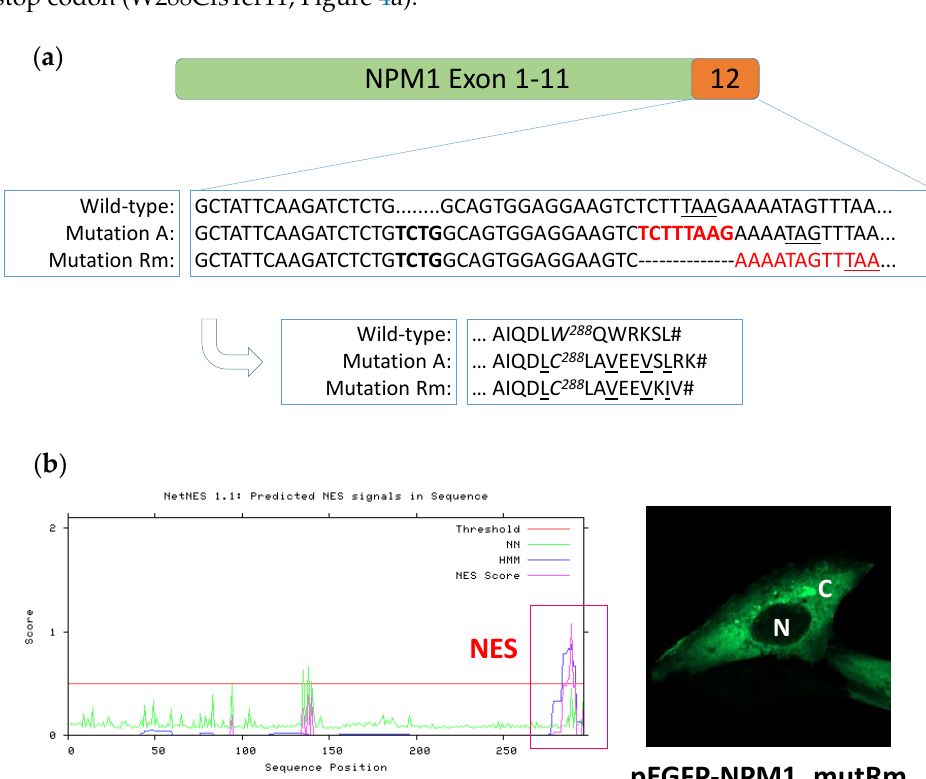
Figure 4. The new NPM1 mutation Rm disrupts the NoLS and inserts a C-terminal NES. ( a ) Nucleotide sequences of exon 12 in NPM1 wild-type, mutation A and new composite mutation Rm, and corresponding predicted protein sequences (arrow). The 4 nucleotide insertion TCTG in mutation A and mutation Rm is highlighted in bold black. The 8 nucleotides lost in composite mutation Rm are highlighted in bold red. The C-terminal NES motifs in mutant A and mutant Rm are underlined. ( b ) Left, NES motif prediction in the new NPM1 mutant Rm. The newly acquired C-terminal NES is highlighted in the red box. Right, representative image of NIH-3T3 overexpressing the new GFP- NPM1 mutant Rm fusion protein. Images were acquired using a Zeiss LSM 800 confocal microscope (Carl Zeiss) with a 488-nm (for eGFP) laser line for excitation, and a 63×/1.4 OIL Plan-Apochromat objective. N: nucleus; C: